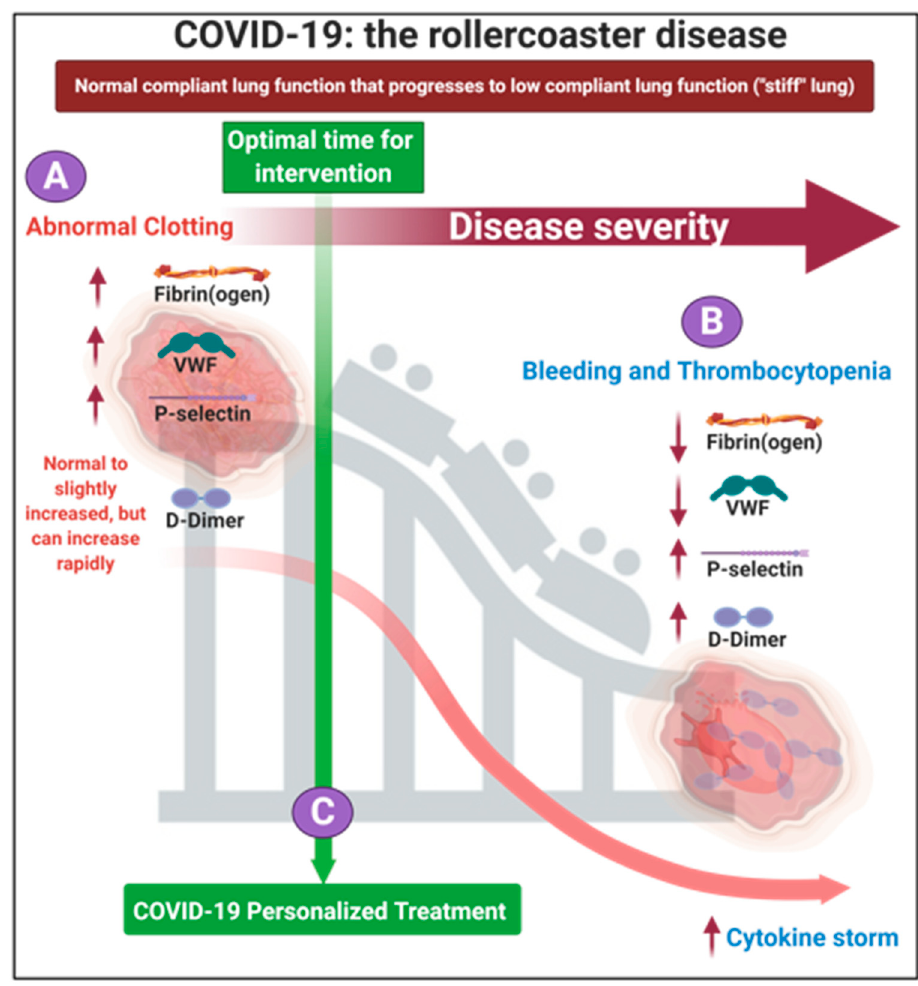
Figure 1. The rollercoaster vascular pathology in acute respiratory syndrome coronavirus 2 (COVID-19) (adapted from [41]). We focus on fibrin(ogen), D-Dimer, P-selectin and von Willebrand Factor dysregulation, resulting in endothelial, erythrocyte and platelet dysfunction. ( A ) Early on in the disease dysregulation in clotting proteins and circulating biomarkers may occur and is suggestive of hypercoagulation. ( B ) The disease may progress to bleeding and thrombocytopenia. ( C ) We suggest that each patient could be treated using a personalized medicine approach in the early stages of the disease. Image created with BioRender (https://biorender.com/ (accessed on 15 October 2021)).